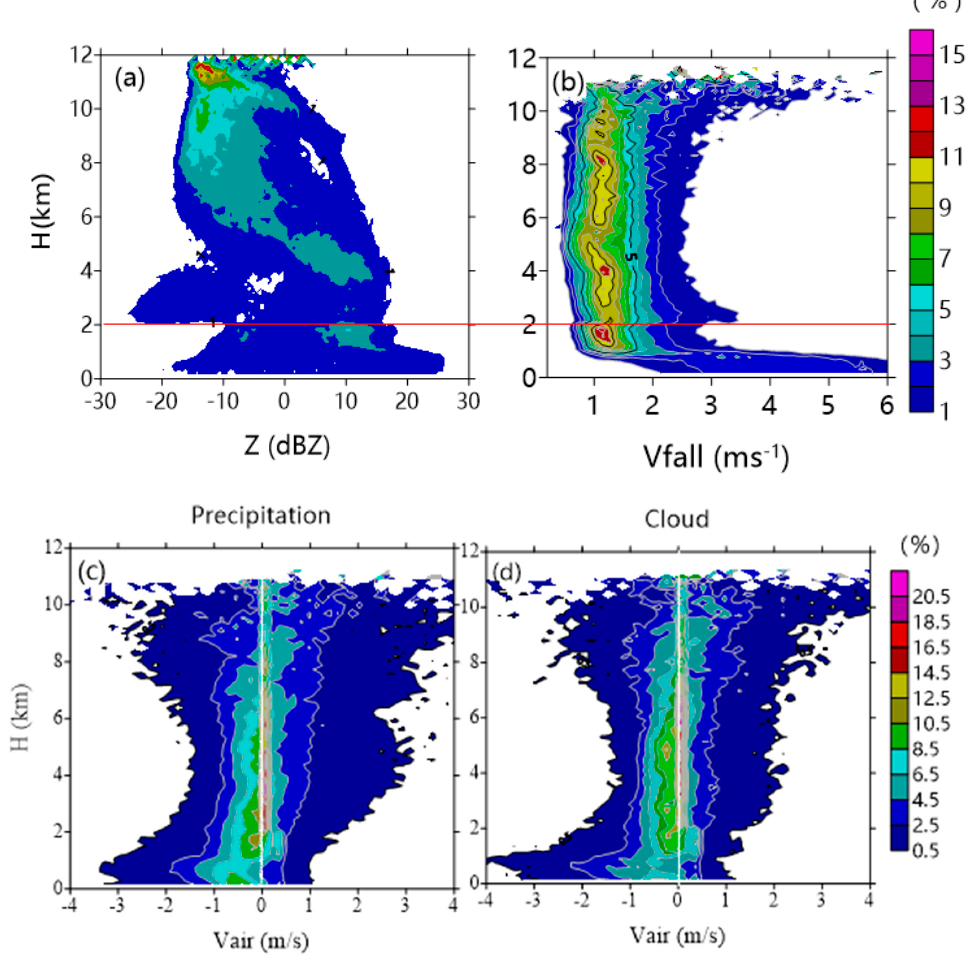
Figure 6. Contoured frequency altitude diagrams (CFADs, %) of ( a ) reflectivity, ( b ) particle fall speed (Vfall), ( c ) vertical air motion (Vair) for precipitation, and ( d ) Vair for non-precipitating clouds during July 2014. The solid red line in ( a ) and ( b ) indicates the minimum observation range of M2, and the dotted white lines in ( c ) and ( d ) are zero of Vair.